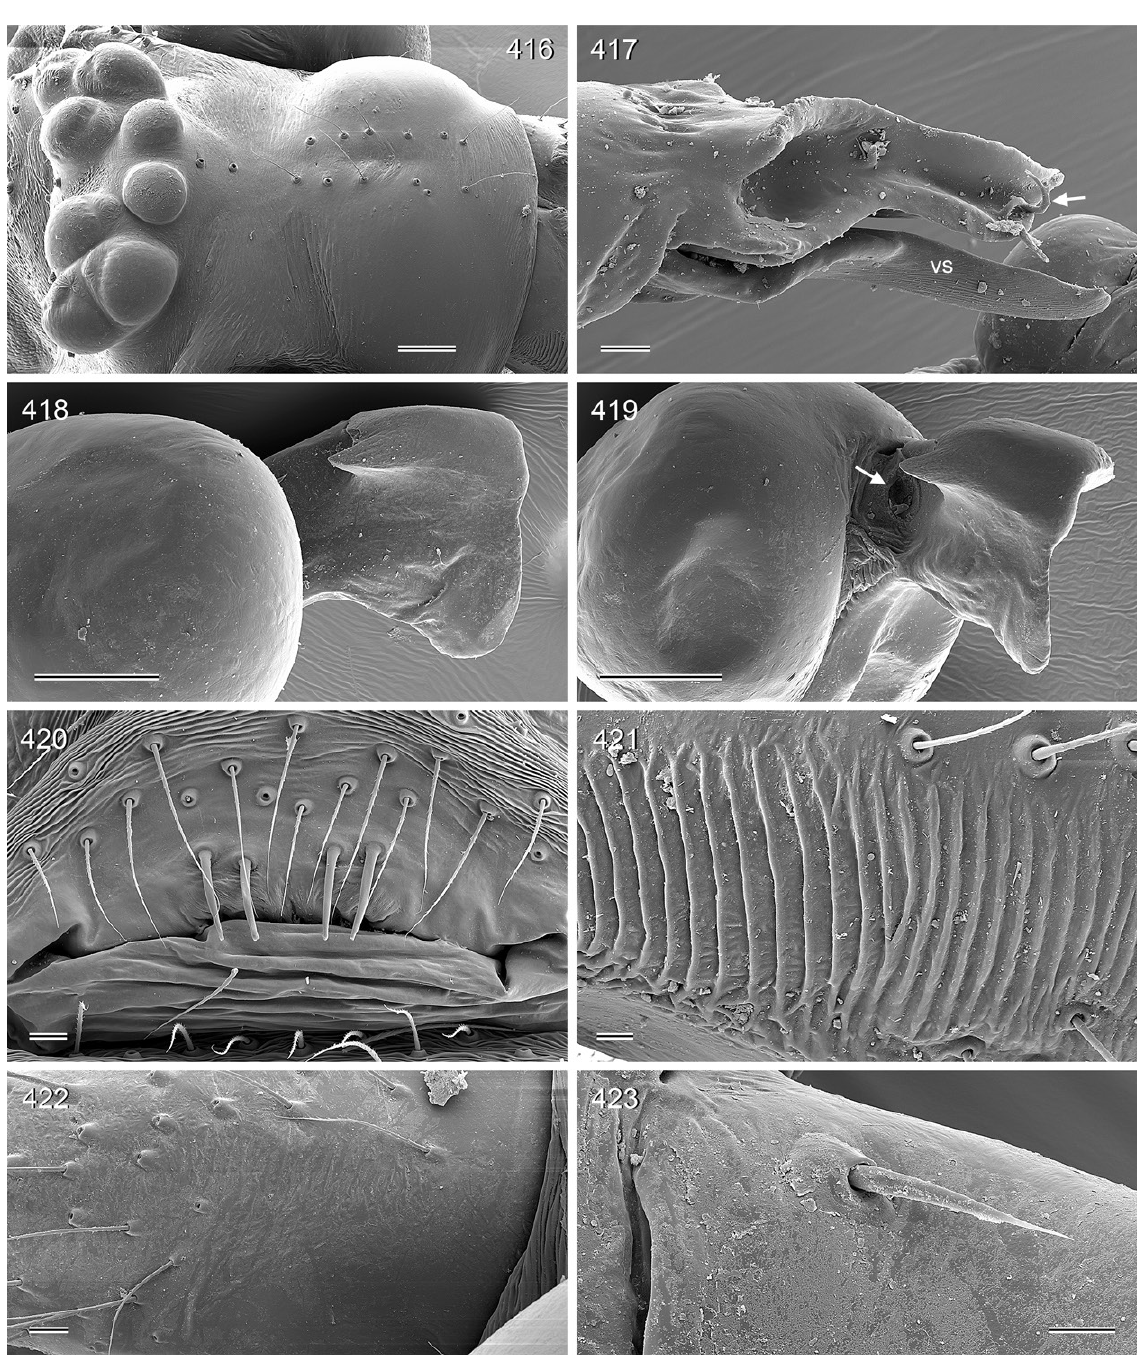
Figs 416–423. Crossopriza sahtan sp. nov.; male and female from Oman, Al Ghubrat cave (ZFMK Ar 22398). 416 . Male ocular area and clypeus. 417 . Right procursus, retrolateral-ventral view; arrow: hair-like process. 418–419 . Left genital bulbs, prolateral and prolateral-distal views; arrow: sperm duct opening. 420 . Male gonopore. 421–422 . Male stridulatory ridges and corresponding smooth female cheliceral side. 423 . Prolateral proximal hair on female palpal femur. Abbreviation: vs = ventral sclerite. Scale bars: 416, 418–419 = 100 µm; 417, 420, 422 = 20 µm; 421, 423 = 10